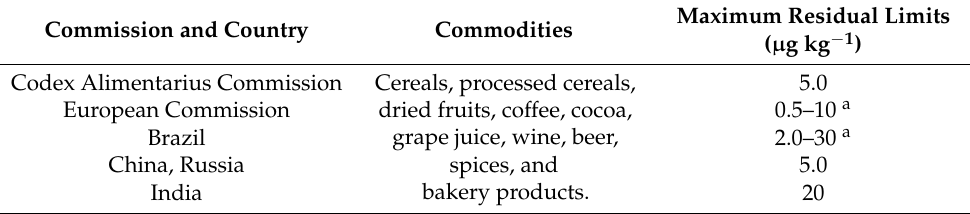
Table 1. An overview of the worldwide legislation on OTA.